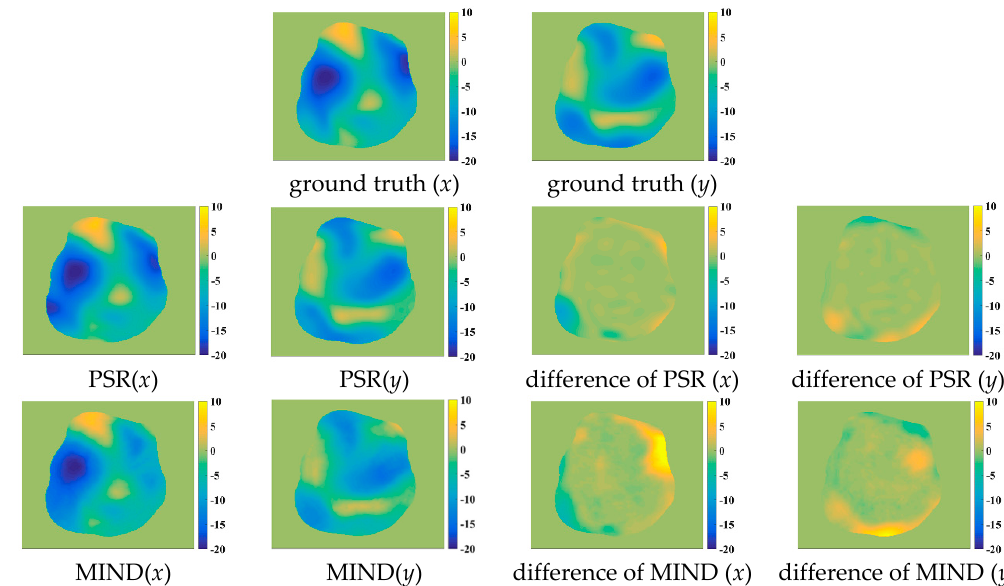
Figure 10. The deformation fields for the various methods. The first row is the ground truth of deformation in the x and y orientations, respectively; the second row is the deformation field of the PSR method and the difference between the PSR and ground truth in the x and y orientations, respectively; the third row is the deformation field of the MIND method and difference between the PSR and ground truth in the x and y orientations, respectively. Table 1. TRE for all registration methods performed on the BrainWeb dataset.